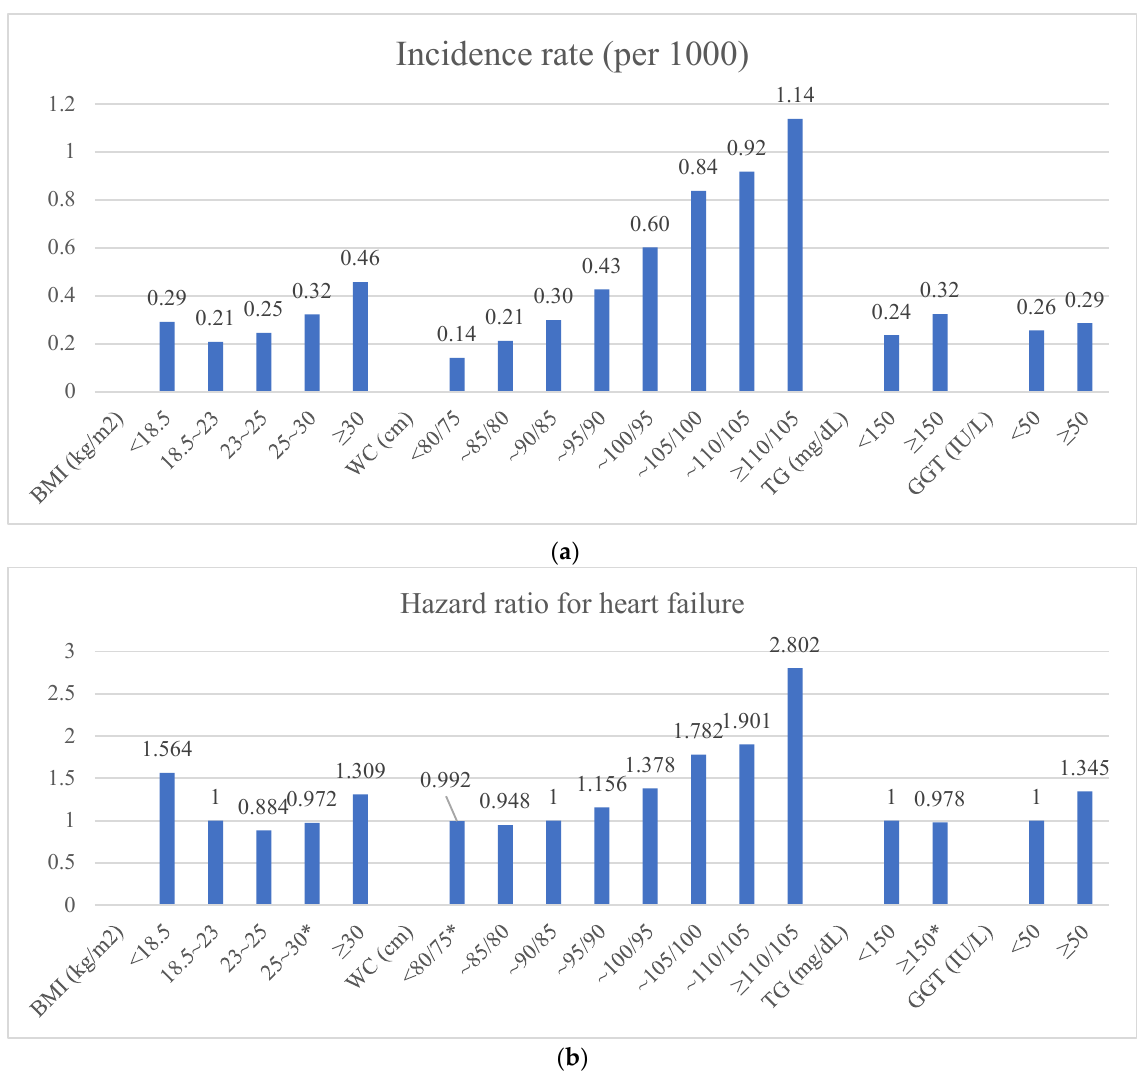
Figure 1. The incidence rate (per 1000 persons) and hazard ratio for heart failure by the components of the fatty liver index. * Statistically not significant. Adjusted for age, gender, smoking, drinking, exercise, diabetes mellitus, hypertension, dyslipidaemia, and BMI. BMI, body mass index; WC, waist circumference; TG, triglyceride; GGT, gamma-glutamyl transferase; Q, quintiles (Q1, Q2, Q3, Q4, and Q5). ( a ) Incidence rate for heart failure per 1000 persons, ( b ) Hazard ratio for the incidence of heart